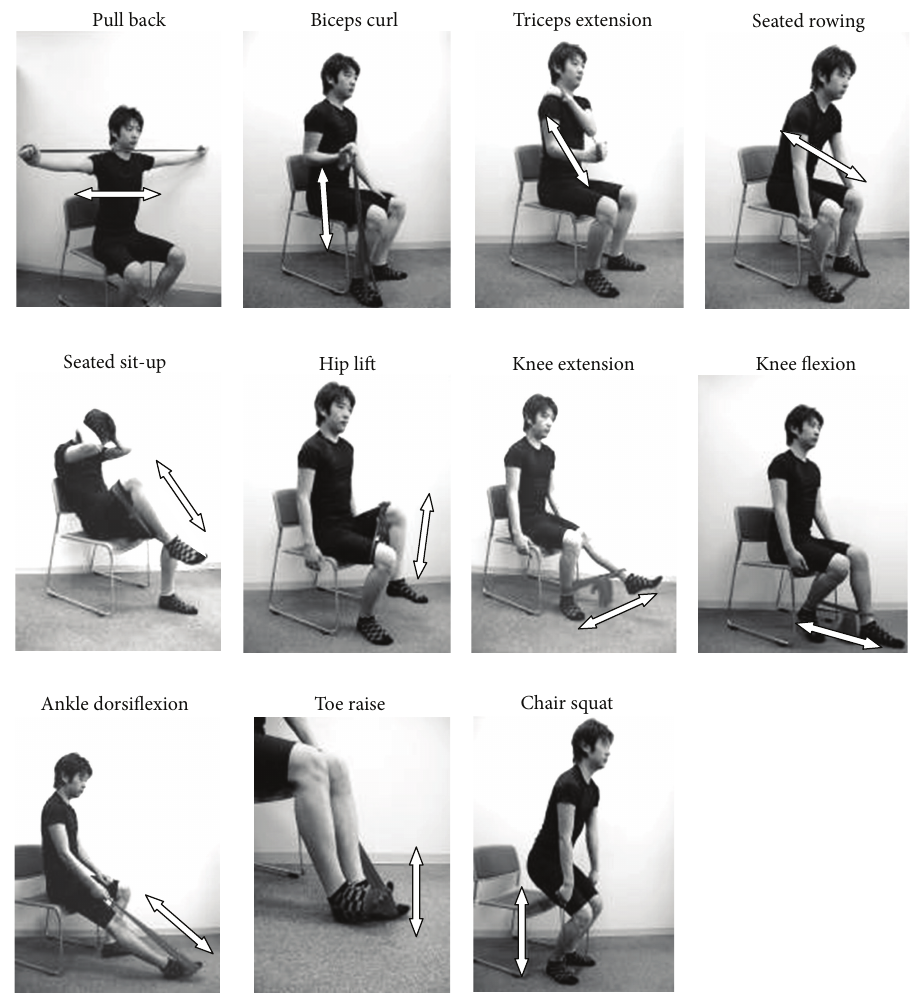
Figure 2: Resistance exercises undertaken in the community- and home-based setting. The resistance training program consisted of exercises that used an elastic resistance band (Thera-Band, Hygenic, USA). Each type of exercise was performed for 12 repetitions/session. Exertion was rated using Borg’s rate of perceived exertion (RPE)